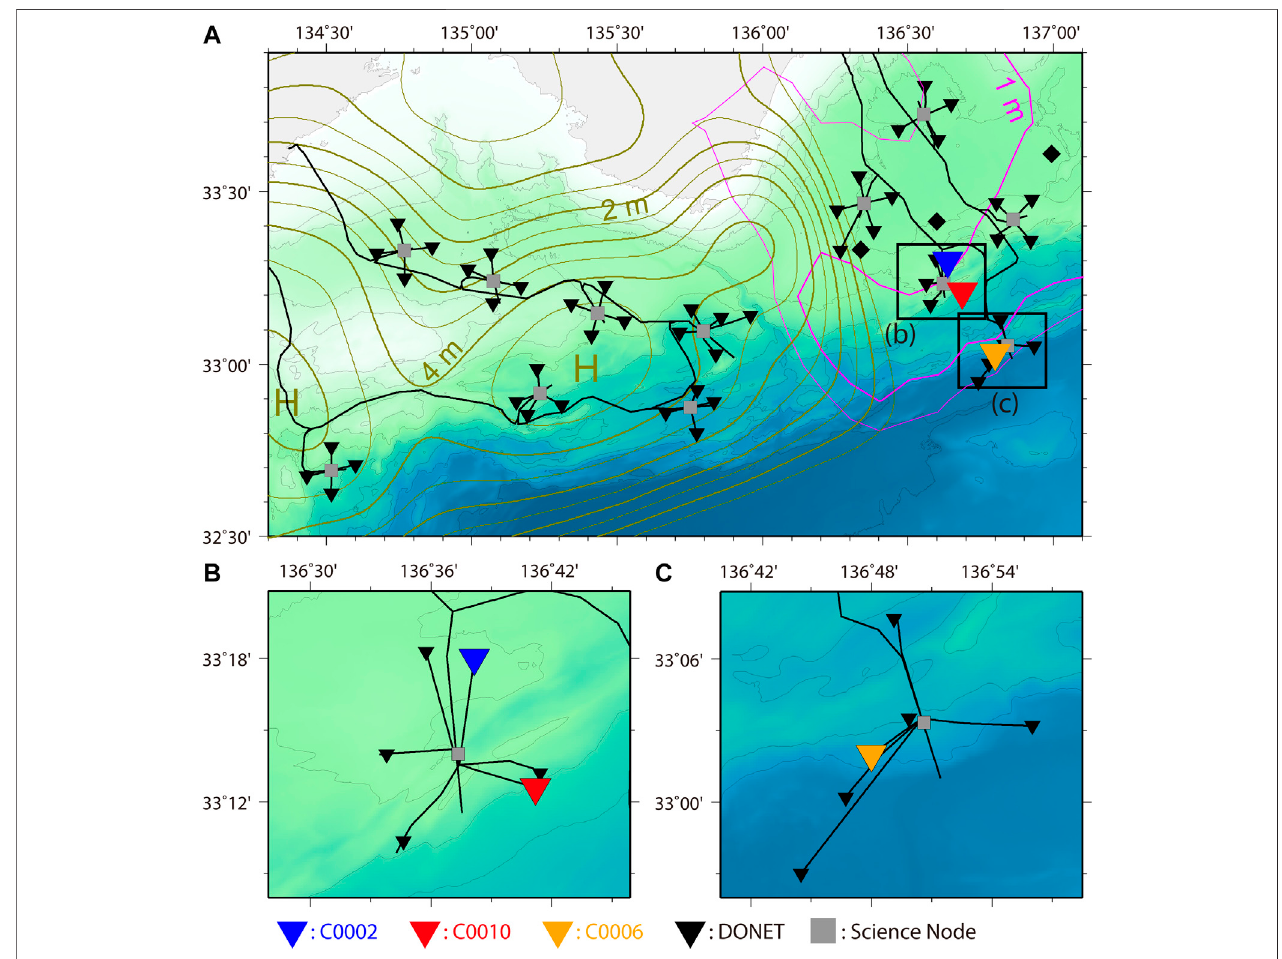
FIGURE 1 | A) Map of the borehole observatories and DONET stations along Nankai Trough. The triangle marks ( ▼ blue, ▼ red, ▼ yellow, and ▼ black) represent C0002, C0010, and C0006 of the borehole observatories and the DONET stations, respectively. The diamonds represent the GNSS-A stations. The magenta and olive contours represent the slip distributions of the 1944 Tonankai and 1946 Nankai earthquakes, respectively (Ichinose et al., 2003; Murotani et al., 2015). Their contour interval is 0.5 m. L and H: regions of low and high slip, respectively. (B) Closeup of C0002 and C0010 of the borehole observatories and D-node of the DONET station. (C) Closeup of C0006 and